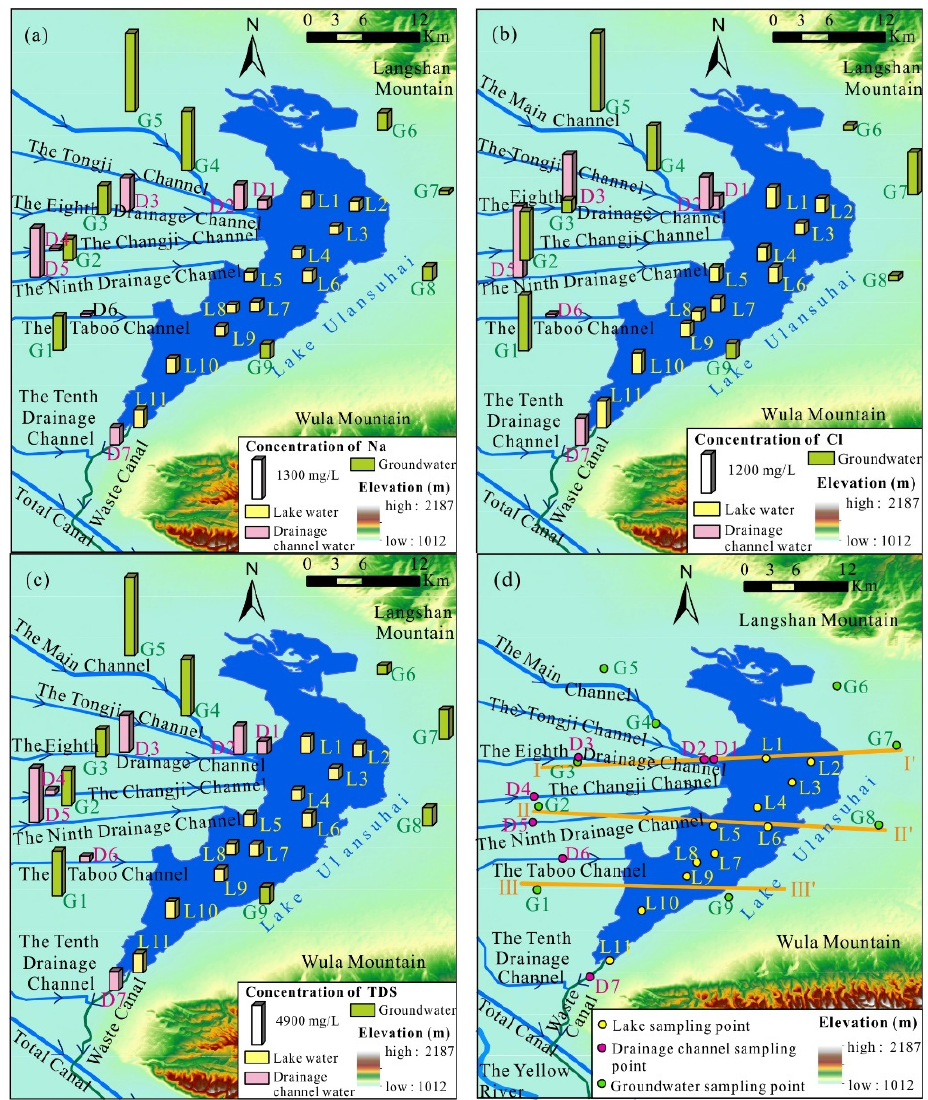
Figure 3. Spatial distributions of ( a ) Na + , ( b ) Cl − , and ( c ) TDS in the three water bodies and ( d ) three section lines.